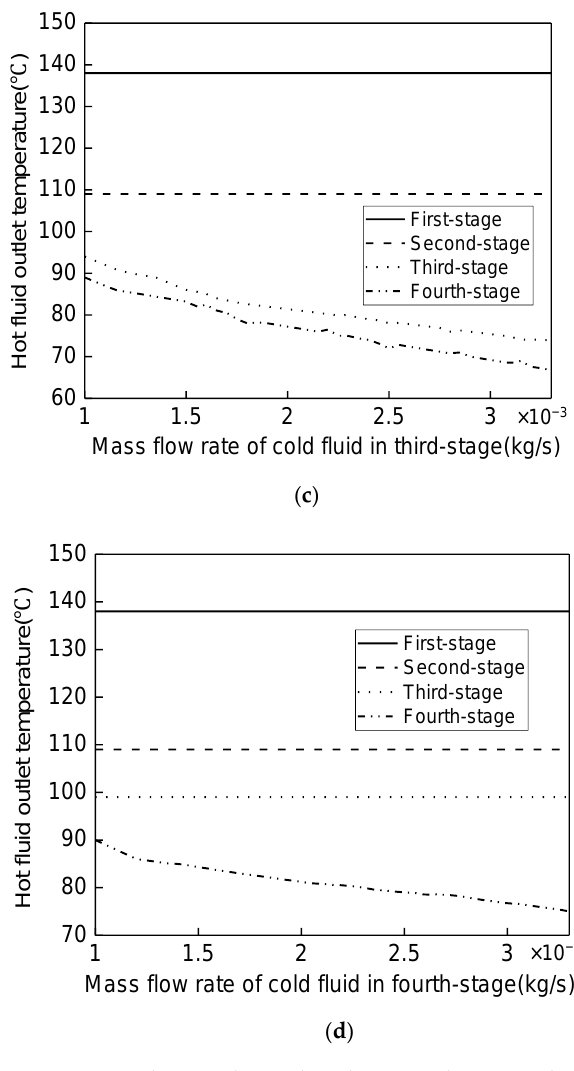
Figure 7. Regulating relationships between the output hot fluid temperature and mass flow rate of the cold fluid in each condenser.